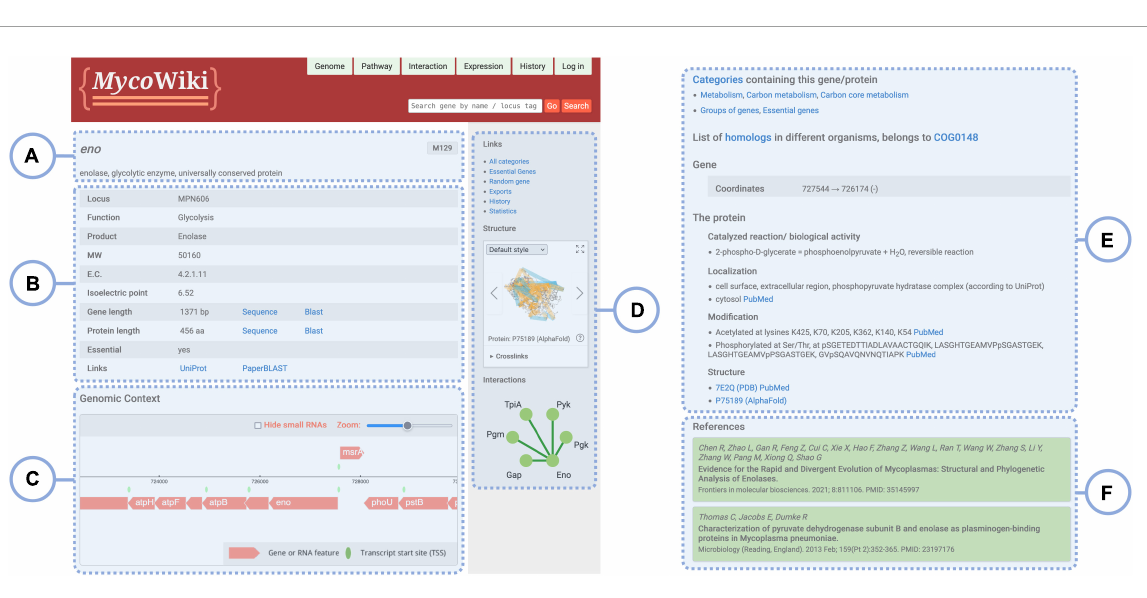
FIGURE2 The gene page for eno . The general structure of gene pages is the same for all genes, but individual sections and interactive elements may vary due to different information being available. (A) Gene name, strain, and description; (B) table summarizing basic information on the gene and its product; (C) embedded genomic region display; (D) sidebar containing helpful links and additional tools, such as the Structure Viewer ; (E) further sections describing various aspects of the gene; and (F) list of publications as sources of